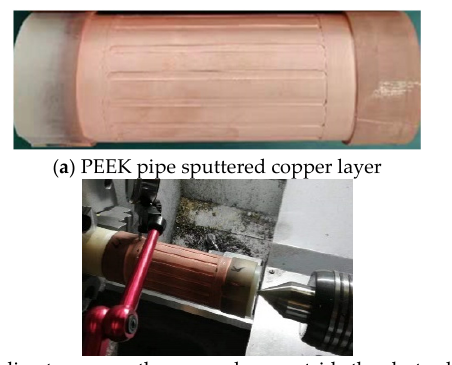
Figure 2. The main process of manufacturing ECT sensor by sputtering process .